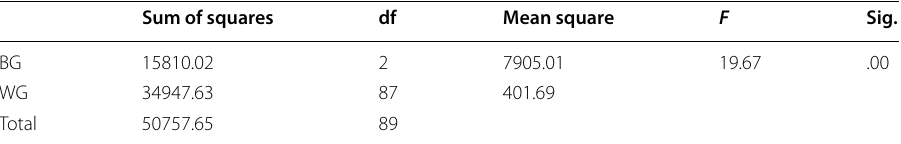
Table 19 Inferential statistics of anxiety posttest of all groups Sum of squares df